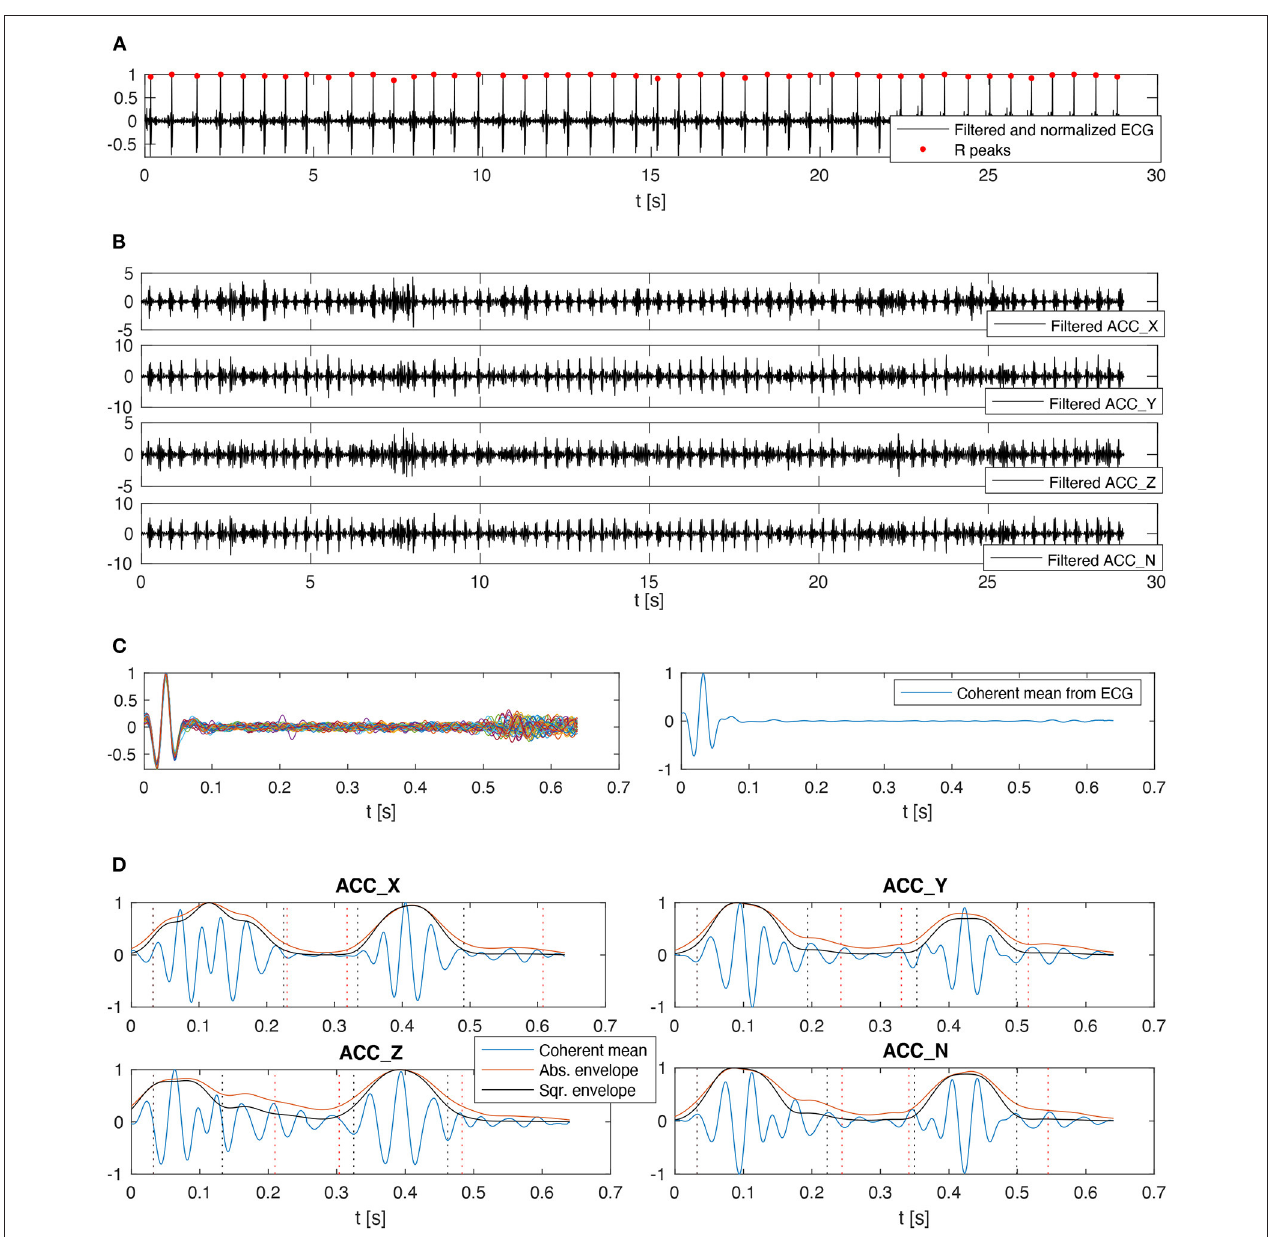
FIGURE 3 | Data processing chain applied to the electrophysiological and mechanical cardiac data. (A) ECG signal after applying baseline removal, filtering, normalization, and QRS detection processes. (B) ACC axes after applying the baseline removal and filtering processes, the N-axis represents the norm. (C) Segmented and aligned ECG cardiac cycles in the left, and the corresponding coherent mean cardiac cycle in the right. (D) Coherent mean cardiac cycle on each ACC axis with their respective envelopes, including candidate detections for S1 and S2. The vertical dotted lines represent t 1, t 2, t 3, and t 4 in red color for Abs and black for